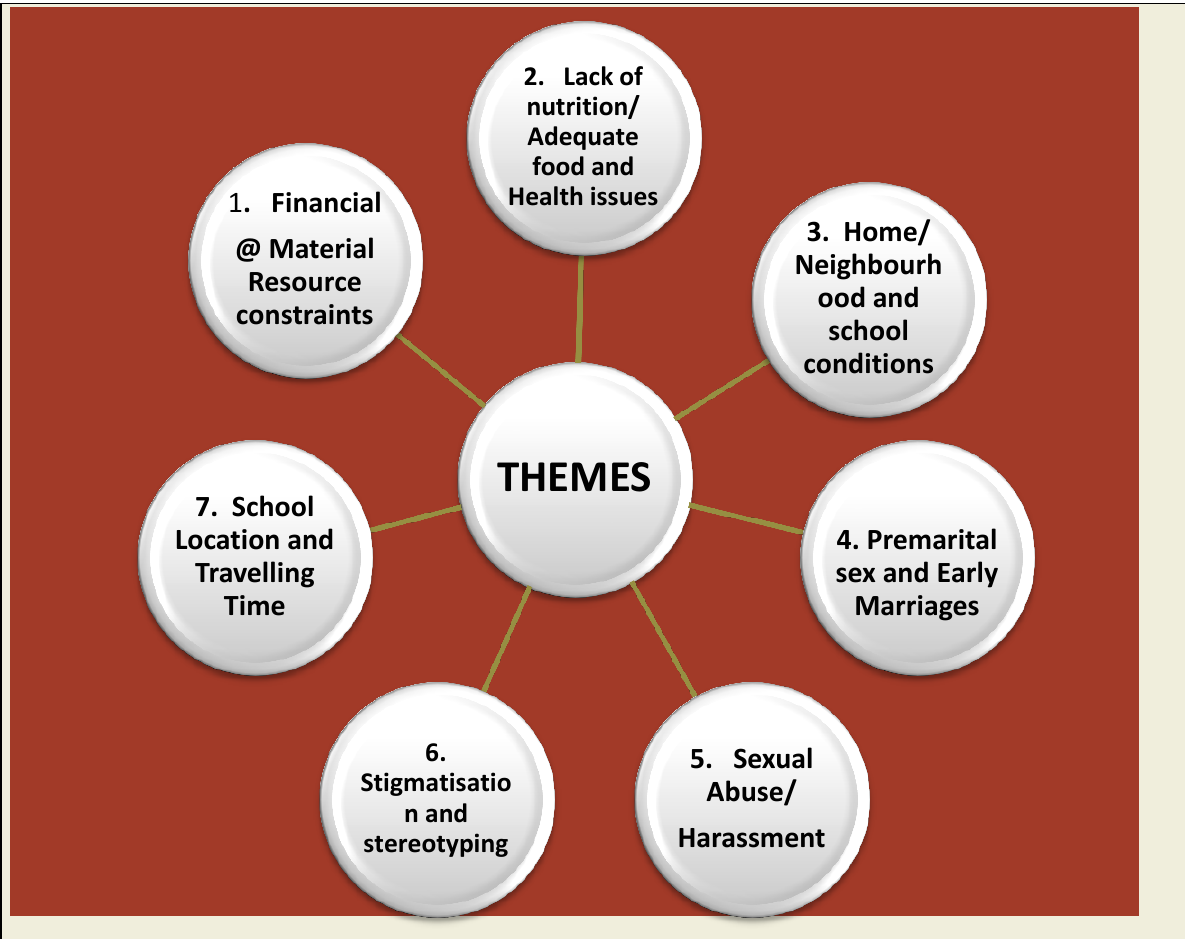
Figure 5.5: Themes derived from the findings of the